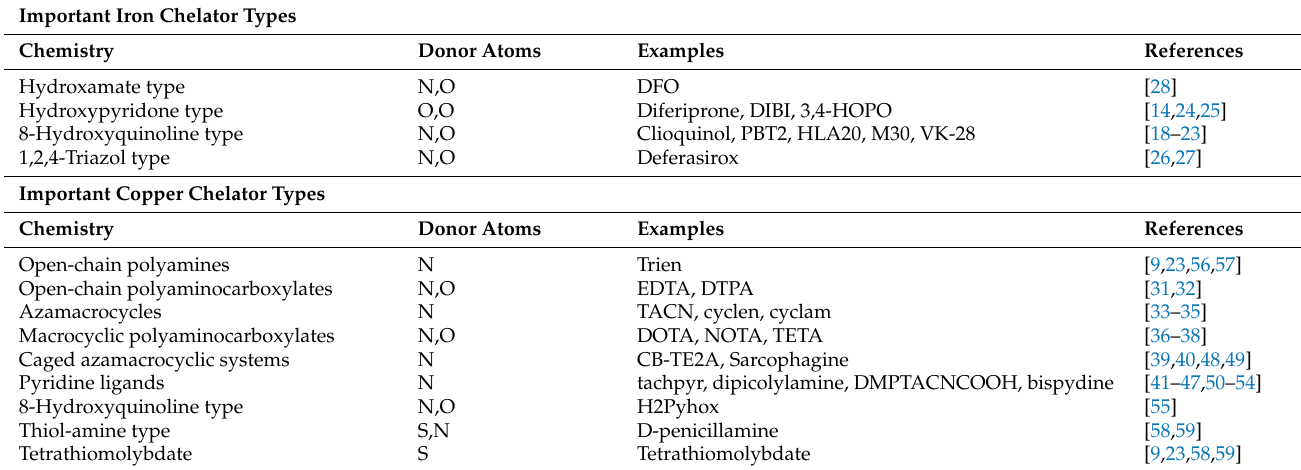
Table 1. Summary of most relevant iron and copper chelator